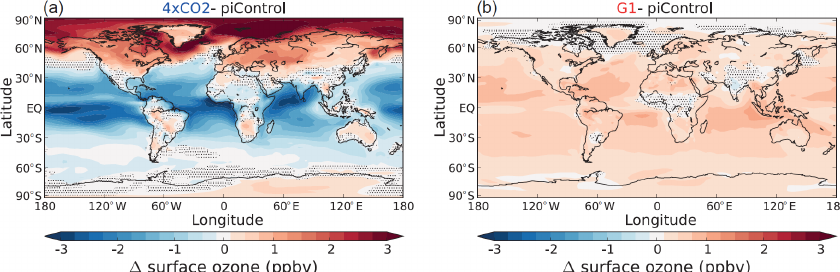
Figure 6. Annual mean surface ozone changes. Absolute values (ppbv). Difference between (a) 4 × CO 2 and piControl, (b) G1 and piControl. Non-significant changes (using a two-tailed Student’s t test at the 95% confidence level) are marked by